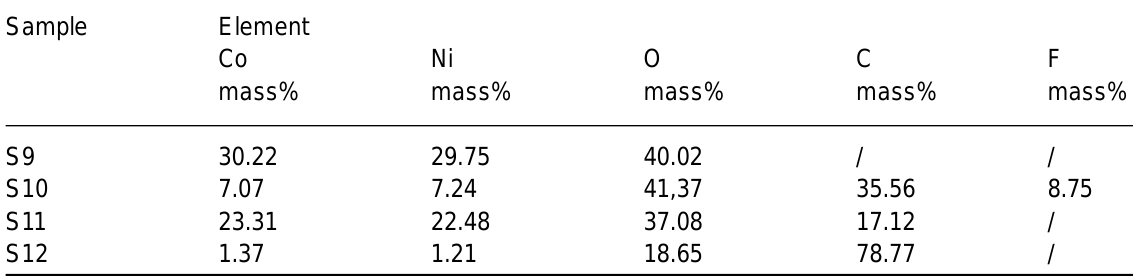
Table 3. EDS results for the elemental composition of the Co-Ni nanoparticles. Sample